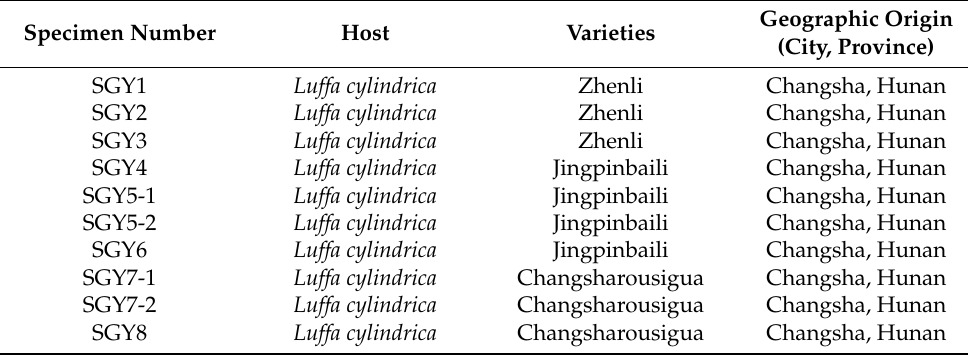
Table 1. The information of the isolates from luffa sponge gourd.